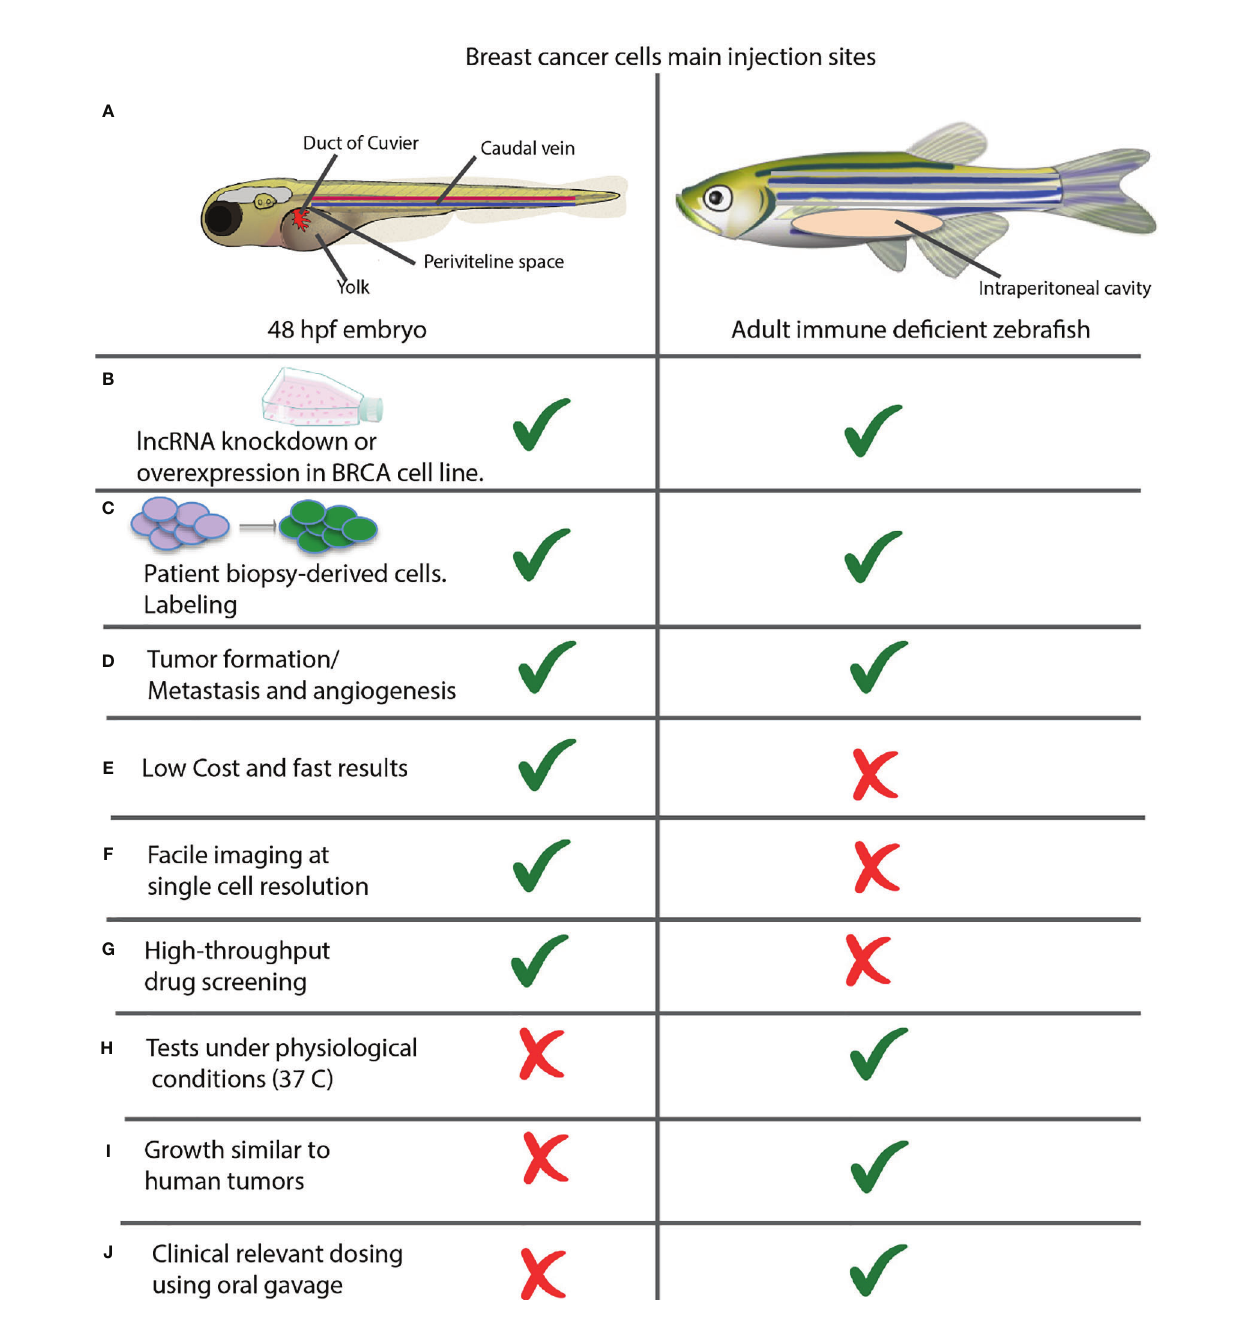
FIGURE 1 | Comparison between xenotransplantation assays in zebra fi sh embryos and adult animals. (A) Common sites of injection. Shown are the most commonly used injection sites for xenotransplantation of a zebra fi sh in two different stages of development. Left: 48 hpf Stage. The yolk sac is the most common site of injection, but hindbrain ventricle, caudal vein; previteline space and duct of cuvier can be used also. Right: Juvenile Adult. The majority of xenografts occur within the intraperitoneal cavity, and hinbrain ventricle can be used also. (B) Xenotransplantation of cancer cell lines and (C) patient-derived cells can be performed in both embryos and adults. (D) Xenotransplantation allows evaluating the rate of tumor formation, metastasis and angiogenesis. (E – J) Advantages and disadvantages of xenotransplantation in embryos versus adult fi sh